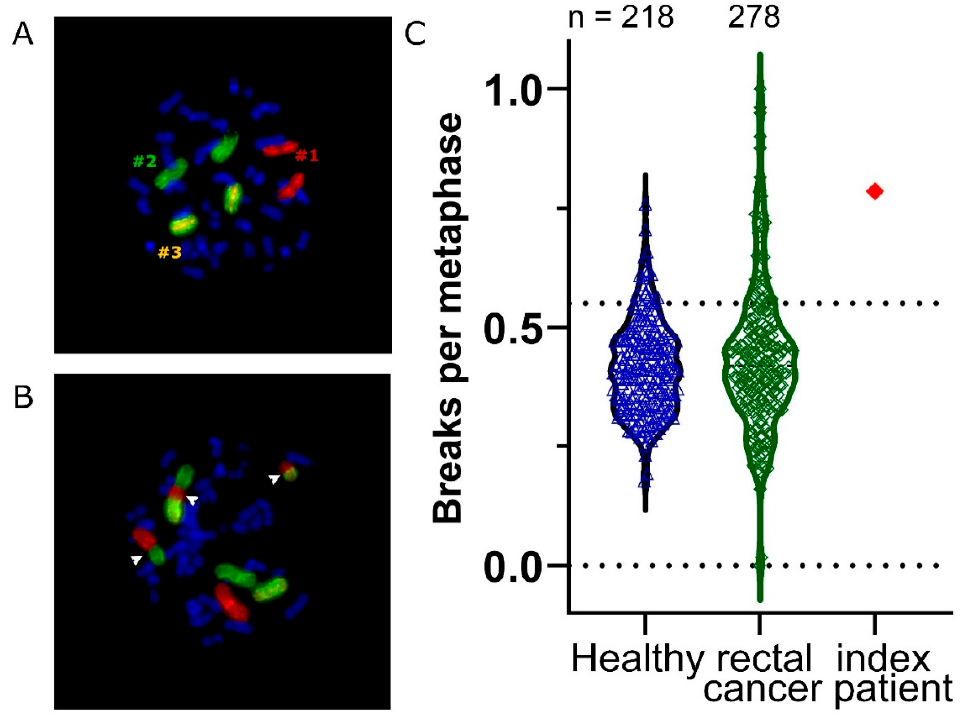
Figure 3. Individual radiation sensitivity analysis by 3-color fluorescence in situ hybridization . ( A ) Metaphase with painted chromosomes #1 in red, #2 in green, and #3 in yellow. ( B ) A metaphase with chromosomal aberrations marked by white arrow heads. ( C ) Breaks per metaphase of the index patient compared to a healthy control cohort and a cohort suffering from rectal cancer.